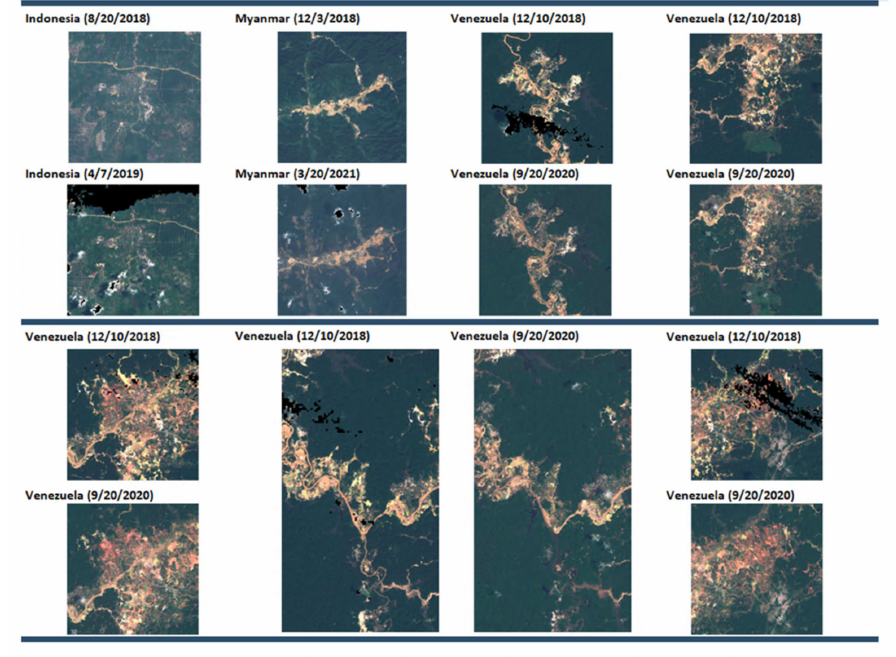
Figure A2. All Test images from Indonesia, Myanmar, and